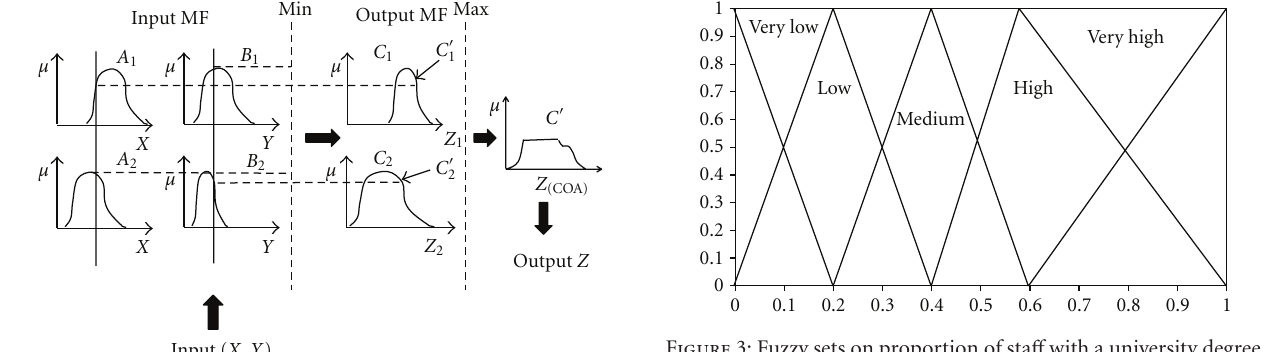
Figure 3: Fuzzy sets on proportion of sta ff with a university